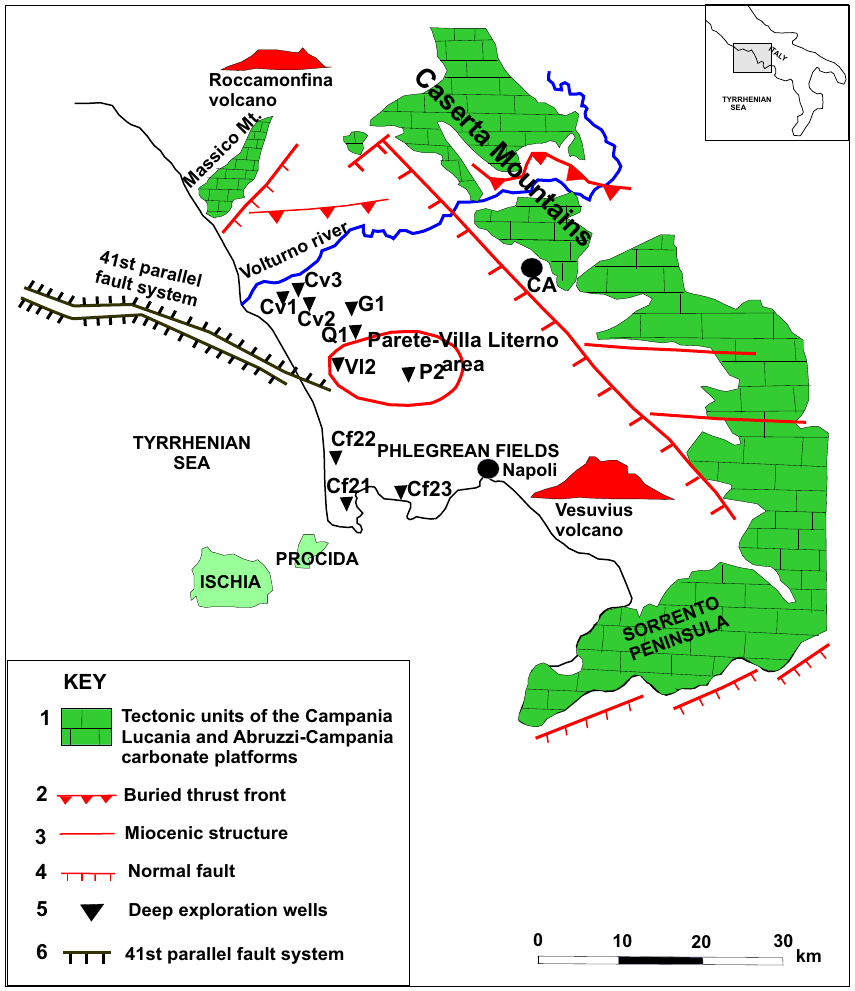
Figure 2. Map of the geology of the area surrounding the Volturno Plain. The location of the deep exploration wells are also shown [from Ippolito et al. 1973, Ortolani and Aprile 1978], onshore in the Volturno Plain, from the mouth of the Volturno River to the Monte di Procida